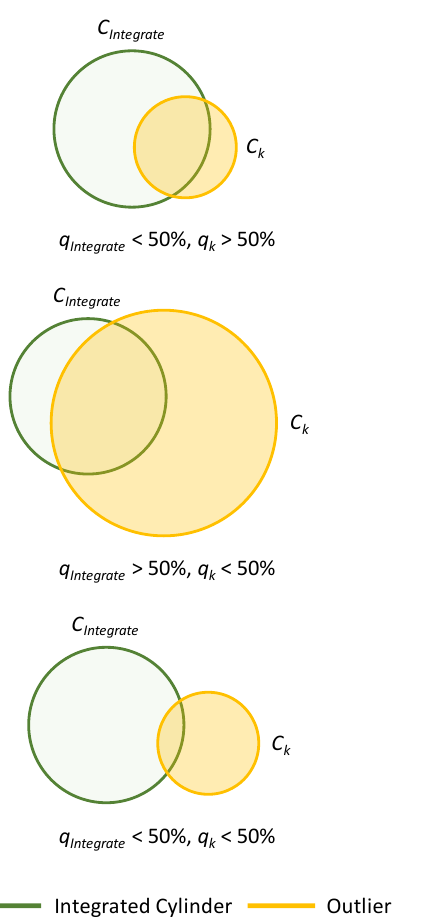
Figure 5. Detection of outlier based on an evaluation of the mutual overlap of the integrated cylinder with the other cylinders of each cluster (2D-view from above, green: integrated cylinder, orange: outlier)